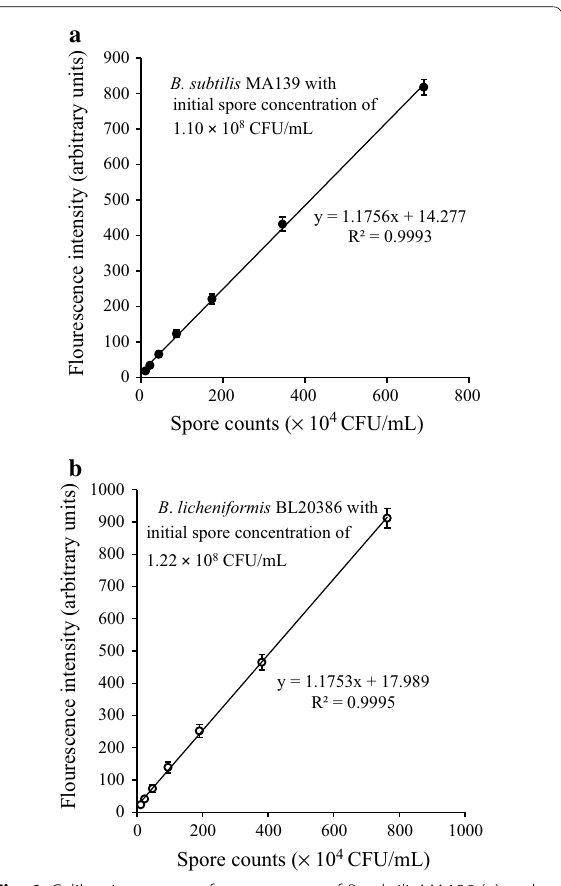
Fig. 6 Calibration curves of spore counts of B. subtilis MA139 ( a ) and B . licheniformis BL20386 ( b ) and their fluorescence